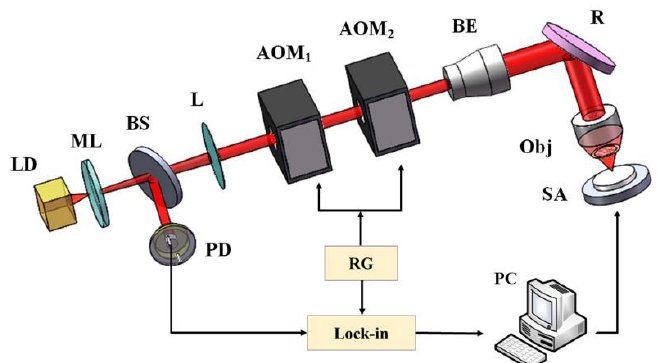
Figure 4. Schematic diagram of the laser confocal feedback tomography. LD: laser diode; ML, microchip Nd:YVO 4 laser; BS, beam splitter; PD, photodiode; L, lens; AOM 1 , AOM 2 , acousto-optic modulators; BE, beam expander; R, Reflector; Obj, objective; SA, sample (phantom); RG, radio-frequency generator; Lock-in, lock-in amplifier; PC, computer.